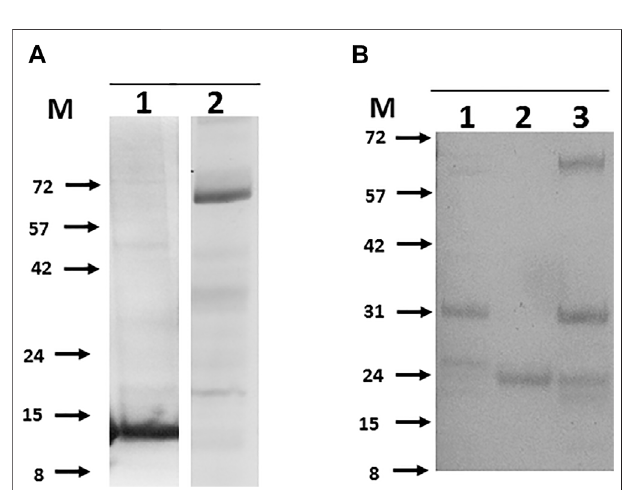
FIGURE5| RescuedexpressionofproblematicbTBproteinsin E.coli by non-His fusion tags. Panel (A) . The secretion accessory proteins EspC and EspA. 1- C-terminally His tagged EspC, 2- N-terminally GFP tagged EspA. Panel (B) . 1-GB_Mb1762 (29 kDa), 2-GB_Mb1916 (25 kDa), 3- GB_Mb2410 (22 kDa) all expressed and puri fi ed as N-terminal fusions with the B1 domain of streptococcal protein G. Molecular weight markers (M) are labelled to left of each panel and are in